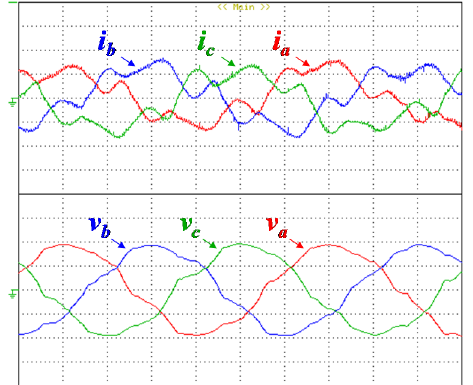
Figure 28. Three-phase currents and voltages when the electric machine operates with a 9 Nm mechanical load (current: 20 A/div; voltage: 20 V/div; time: 5 ms/div).